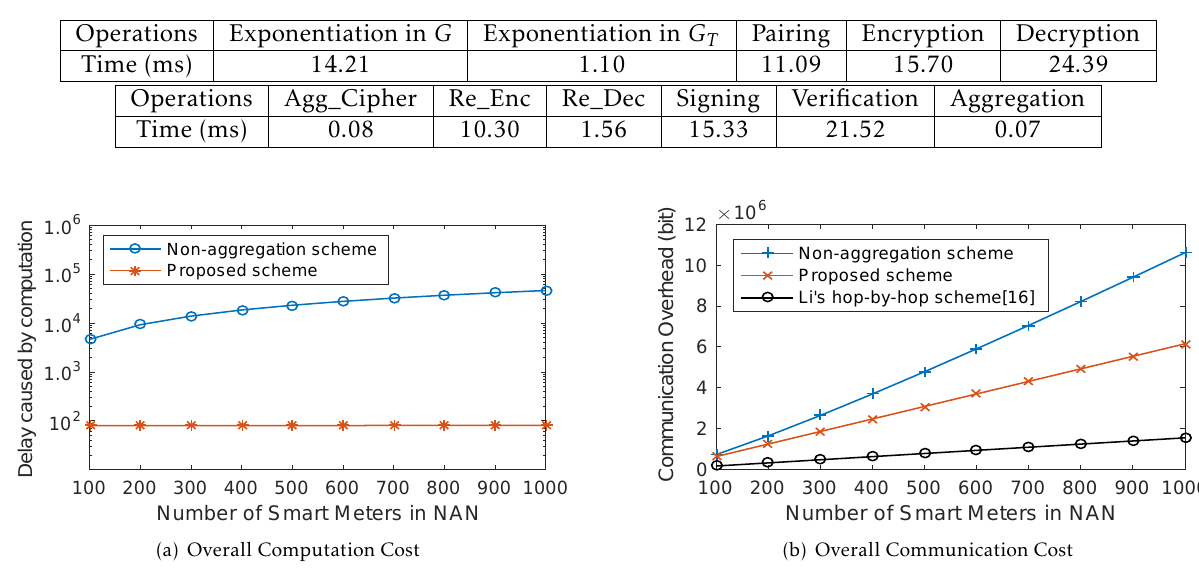
Figure 5. Overall Computation & Communication